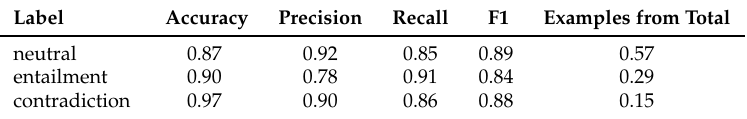
Table 10. SICK-BR NLI results per class, for the fine tuned ptBERT-Large